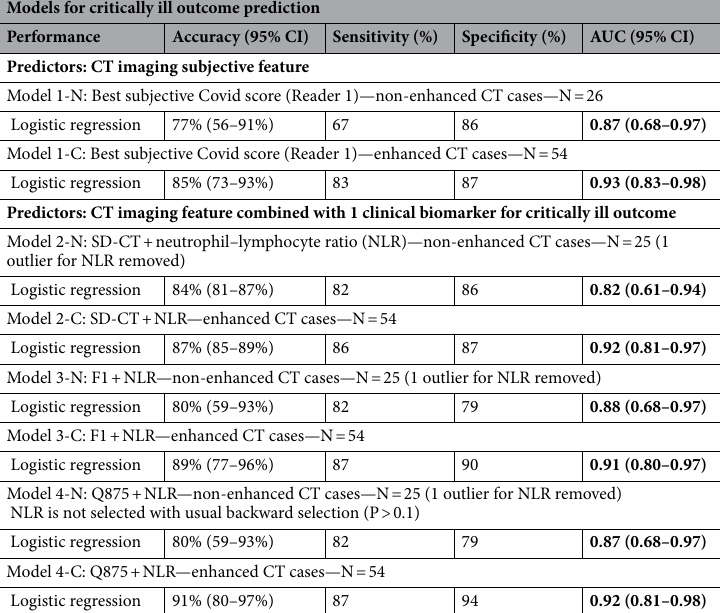
Table 2. Multivariate models for critically ill outcome. The models with the highest AUC values included: reader-1 subjective Covid score in the enhanced CT group, mean CT density + standard deviation CT density in the enhanced CT group and Standard deviation CT density + NLR in the enhanced CT group. (95% CI = 95% confidence